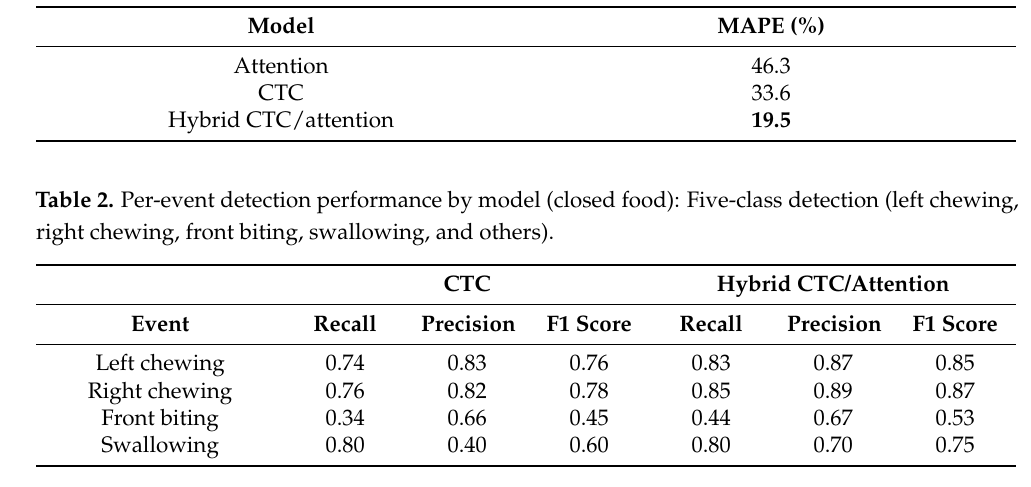
Table 3 overviews a comparison of the detection performance of the entire event for each feature. The detection performance was low when only the left or the right signal was used because the information of left and right chewing was barely included. The proposed